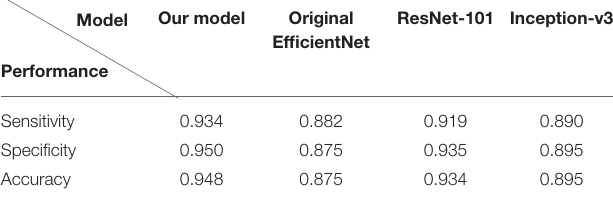
TABLE 3 | The detailed overall sensitivity, specificity and accuracy of our and other 3 CNN